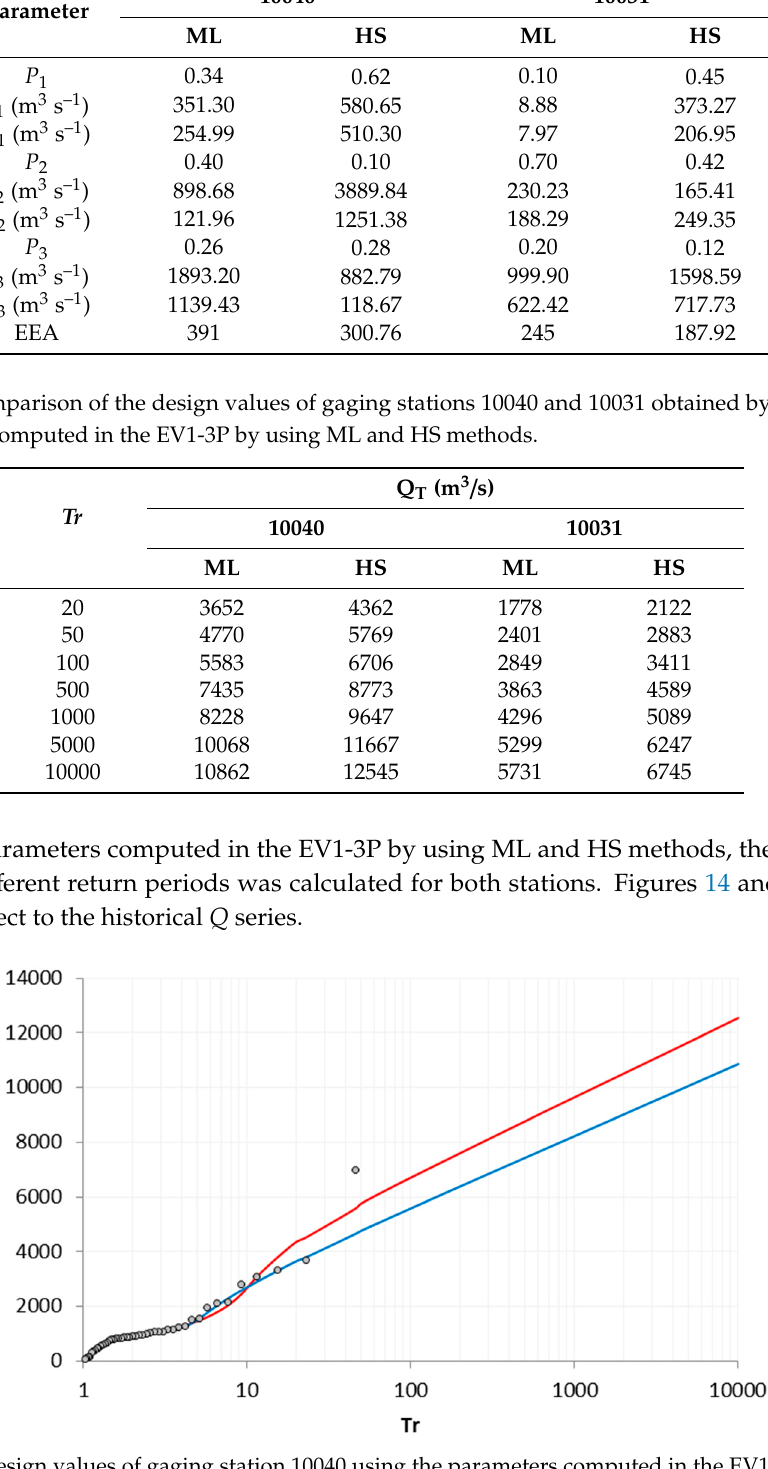
Figure 14. Design values of gaging station 10040 using the parameters computed in the EV1-3P by ML ( ) and HS ( ).